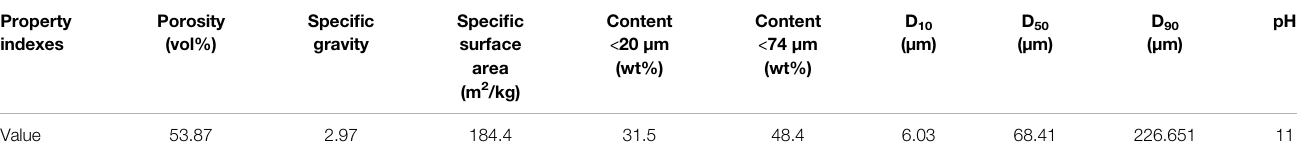
TABLE 1 | Physical properties of the main tailings. Property indexes